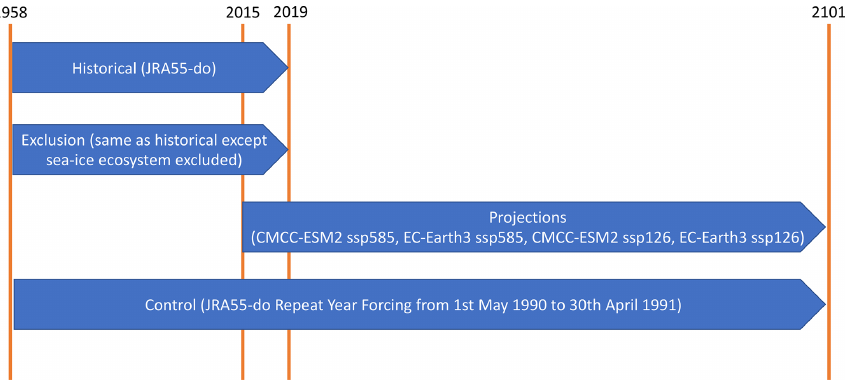
Figure 2. Timeline of the numerical experiments of IAMIP2. Years begin on January 1. Each experiment starts on 1 January and ends on 31 December . For example, the historical experiment starts from 1 January 1958 and ends on 31 December